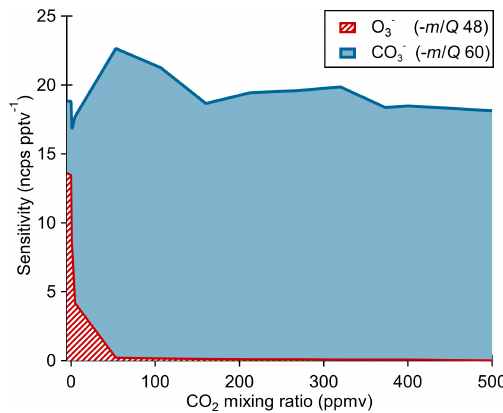
Figure 4. Ox-CIMS cumulative sensitivity to O 3 detected either di- rectly as O − or as CO − as a function of CO 2 mixing ratio. The sum 3 3 of sensitivity as O − and CO − shows that total sensitivity to O 3 is 3 3 conserved as the product distribution shifts with CO 2 mixing ratio. More than 99% of O 3 is observed as CO − at CO 2 mixing ratios 3 greater than